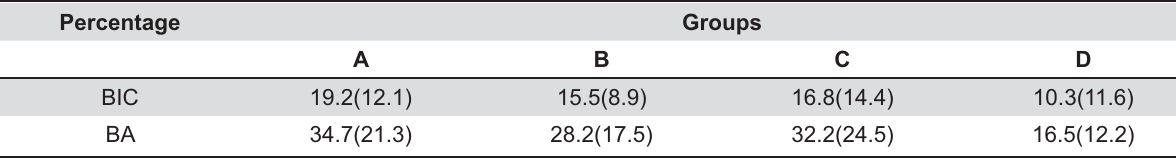
BIC: Bone-implant contact; BA: Bone area in